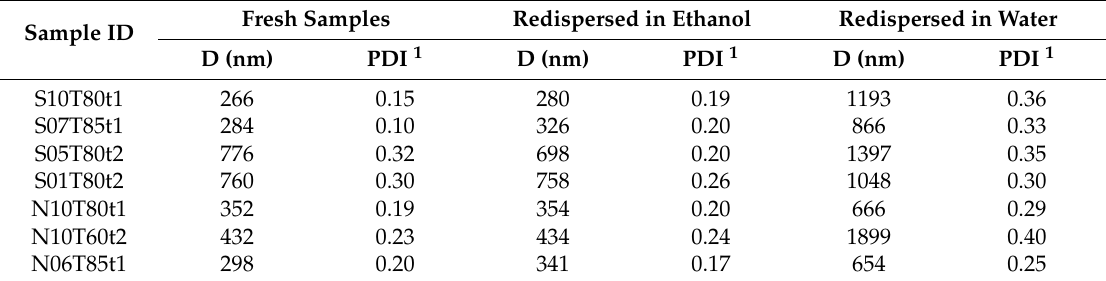
Table 2. Size and size distribution of PeM-CNPs by dynamic light scattering (DLS) measurements.